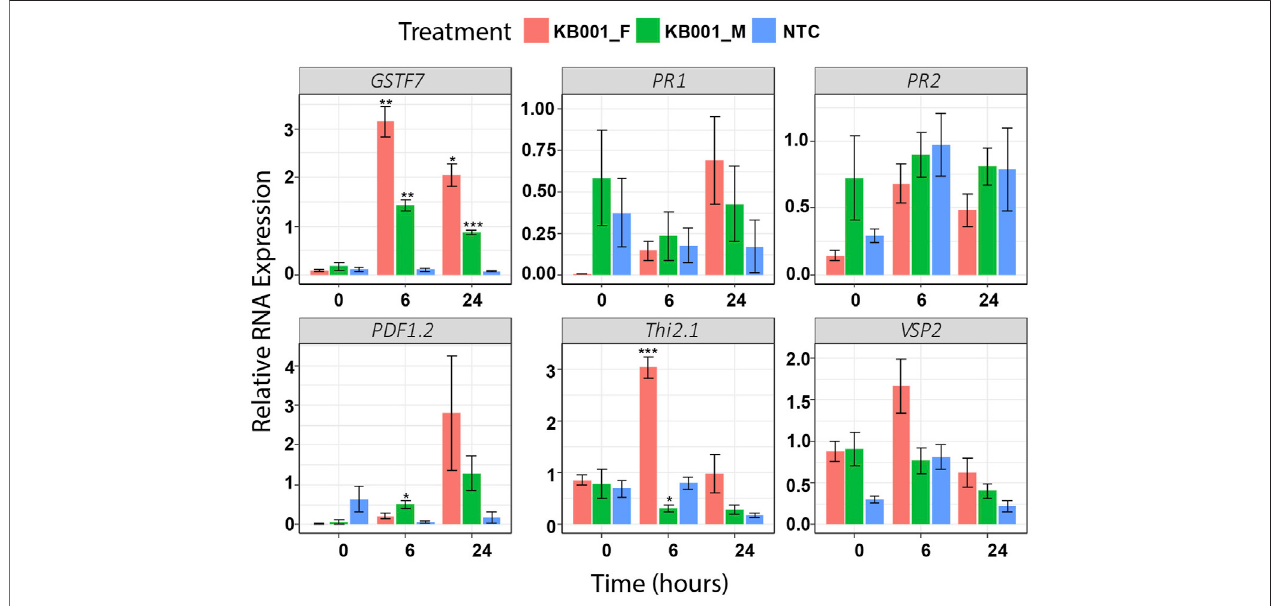
FIGURE 4 | Treatment of KB001-induced stress marker expression in Arabidopsis. 10-day-old Arabidopsis seedlings were either treated with KB001 culture media(KB001_Microbe),theKB001culture fi ltrate(onlycontainssecretedcompounds,KB001_Filtrate),orwerenottreated(NTC).RNAwasextractedbeforetreatment (time (cid:1) 0),6and24 hposttreatment,andgeneexpressionwasmeasuredusingqPCR.Shownistheaverageoffourbiologicalreplicates.A t -testwasusedtodetermine signi fi cant differences to NTC samples. * p < 0.05; ** p < 0.01; *** p <